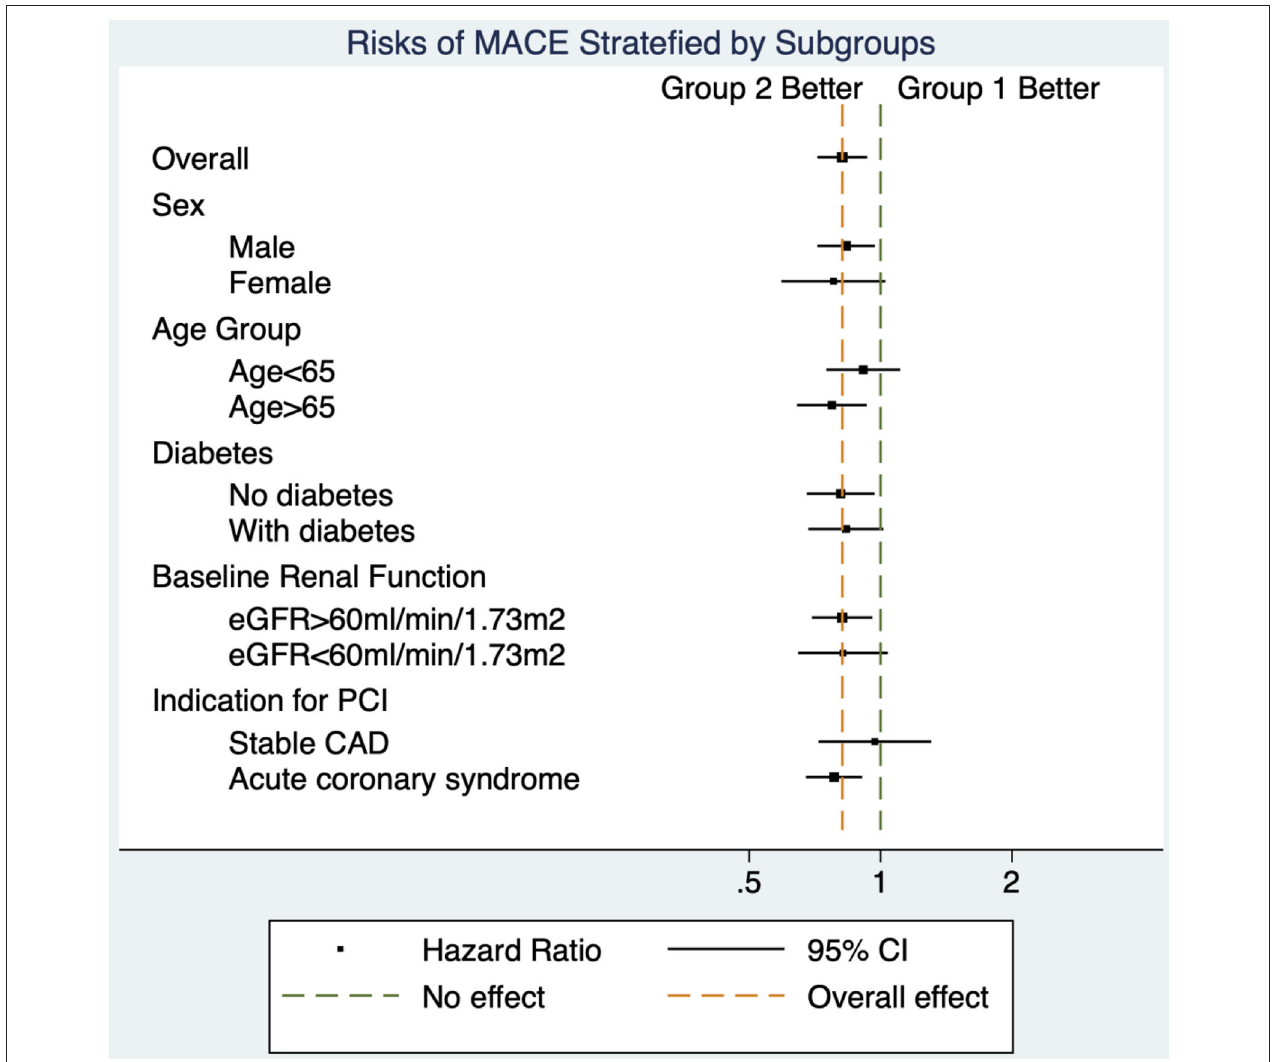
FIGURE 4 | Forest plot for subgroup analyses. The decreased risks of major adverse cardiovascular events in group 2 (intensity criteria only) compared with group 1 (target criteria only) were similar across all